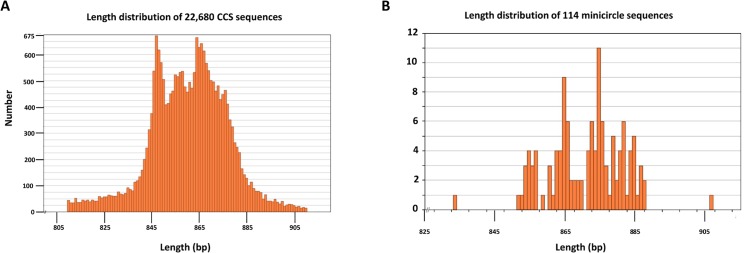
Length distribution of minicircles.A. Length distribution of 22,680 randomly single cleaved minicircle DNA molecules sequenced on PacBio platform. B. Length distribution of the final dataset of 114 minicircles.